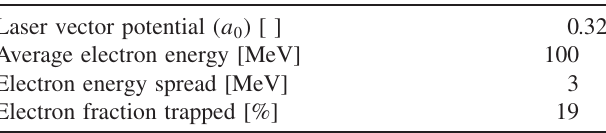
TABLE III. Final properties of the electron bunch injected 300 fs behind the laser